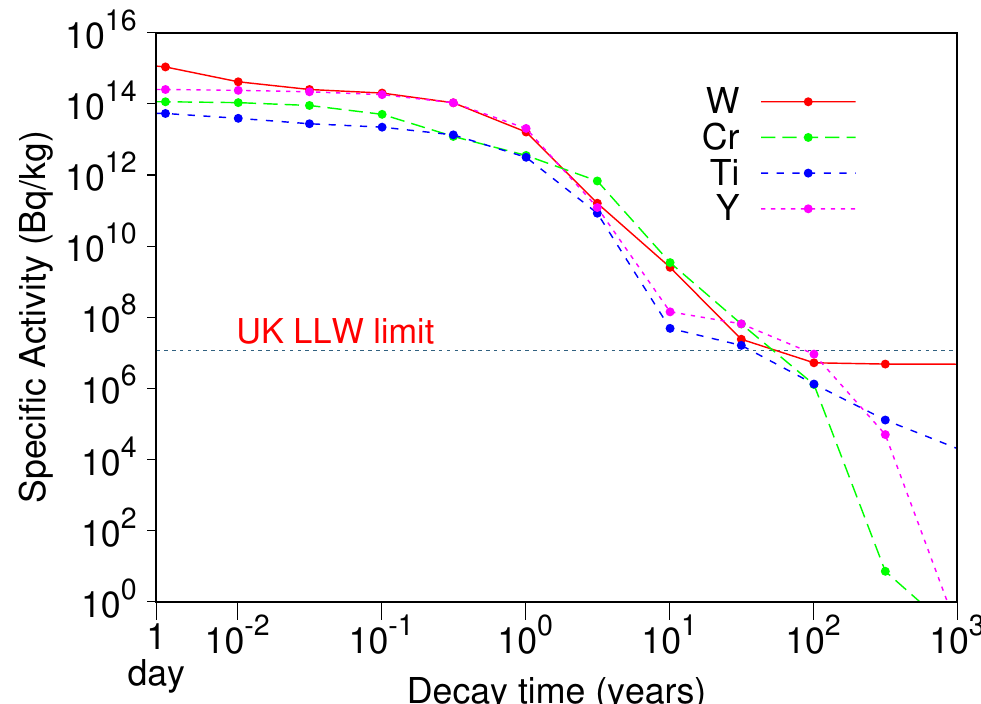
Figure 2. Radiological response represented by total activity in Bq/kg of W, Ti, Cr, and Y during decay cooling following a two full power year exposure under typical fusion first wall conditions, in reference to UK LLW (low level waste)